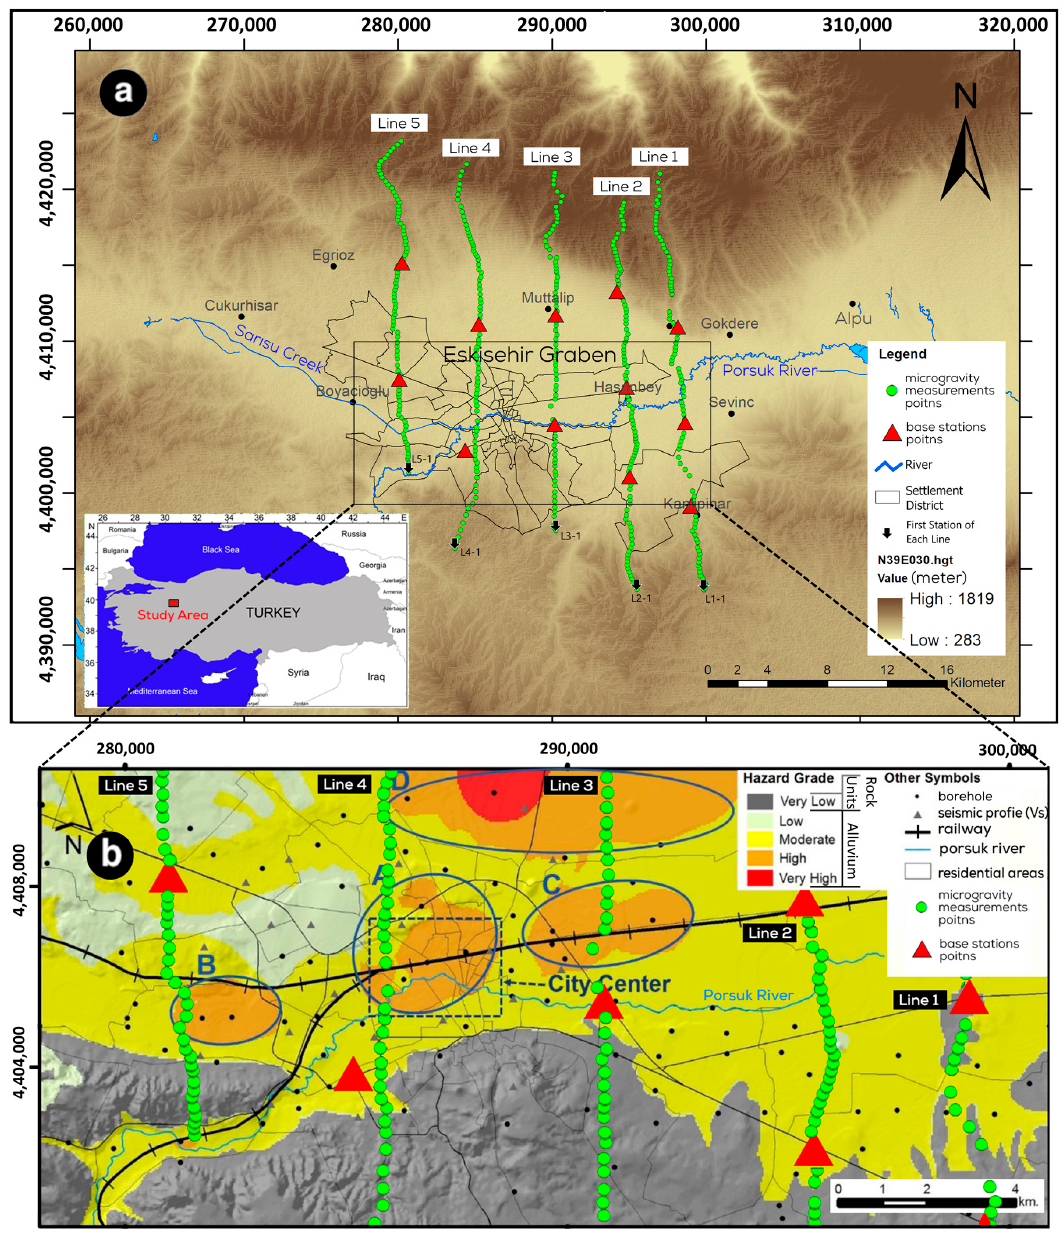
Figure 1. ( a ) A general map of gravity measurement locations in study area. ( b ) A map showing areas at risk for liquefaction and soil amplification: Zone A (high seismic risk); high population ratio and high seismic hazard, Zones B and C (medium seismic risk); lower population ratio and high seismic hazard, Zone D (low seismic risk); extremely low population ratio and very high seismic hazard [1] and gravity measurement locations in Eskisehir City Center (datum: WGS84 UTM Zone 36